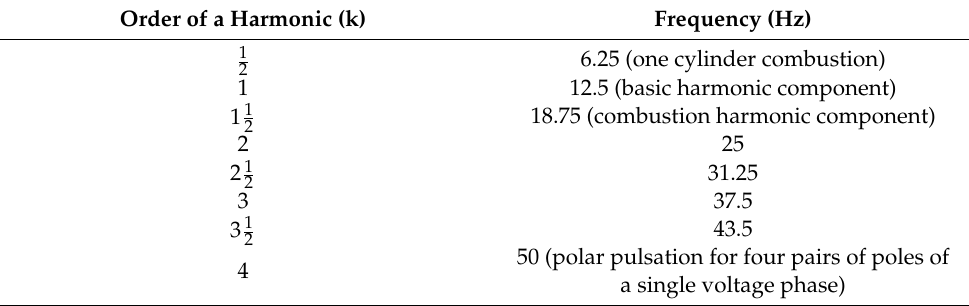
Table 2. Orders of selected harmonic components and corresponding frequencies.